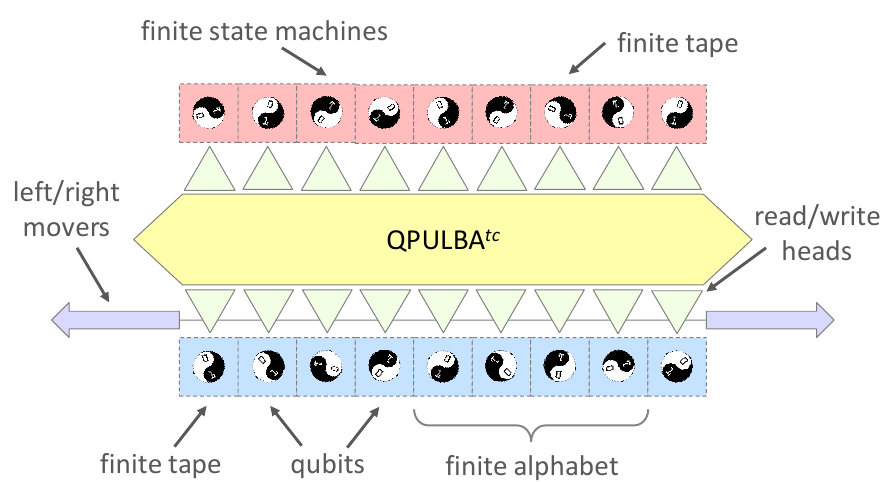
Figure 3. QPULBA tc : Quantum Parallel Universal Linear Bounded Automata restricted by t cycles and tape length c .